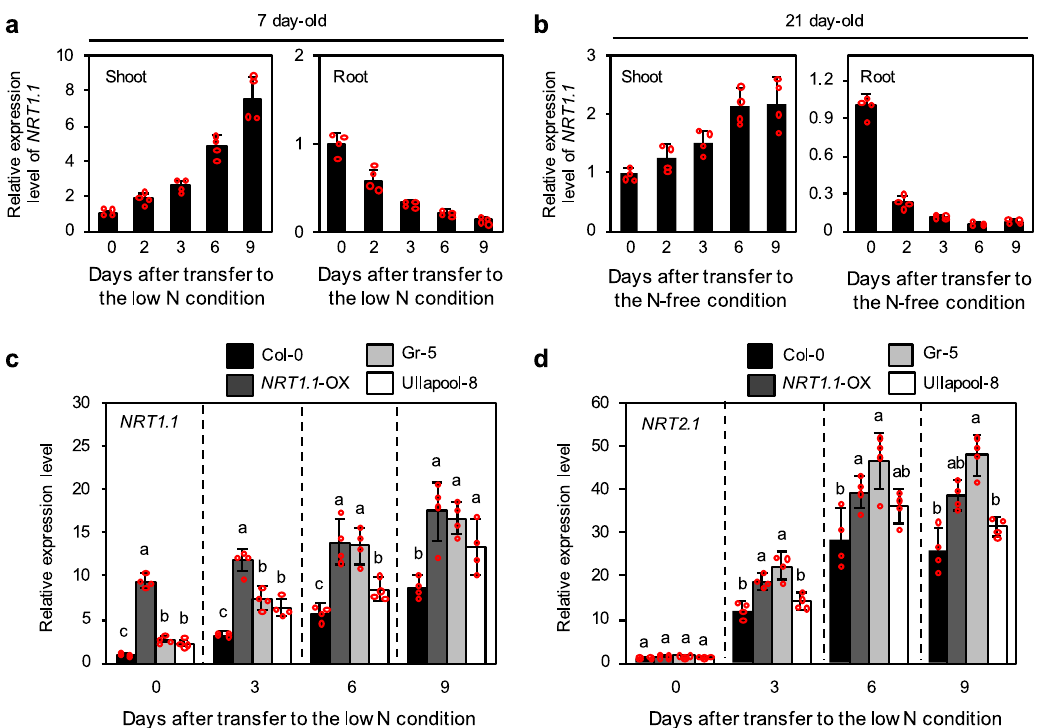
Fig. 4 N de fi ciency-induced changes in expression levels of NRT1.1 and NRT2.1 . a , b Transcript levels of NRT1.1 in the shoots and roots of Col-0 seedlings grown on 1/2 MS agar plates ( a ) or in hydroponic medium ( b ). In a , seedlings were grown with continuous light for 7 days on 1/2 MS agar plates and then under the low N condition (0.3 mM N) for the indicated time periods. In b , seedlings were grown hydroponically in 1/10 MS medium for 21 days under continuous light and then in N-free 1/10 MS medium for the indicated time periods. c , d Expression levels of NRT1.1 ( c ) and NRT2.1 ( d ) in the shoots of Col- 0, NRT1.1 -OX, Gr-5, and Ullapool-8 seedlings grown on 1/2 MS agar plates with continuous light for 5 days and then under the low N condition for the indicated duration. In a – d , transcript levels of each gene were normalized against transcript levels of ACT2 and then against the value obtained from samples at time zero. Data represent mean ± SD of four biological replicates. Different lowercase letters indicate signi fi cant differences ( p < 0.05; ANOVA followed by Tukey ’ s post-hoc comparison